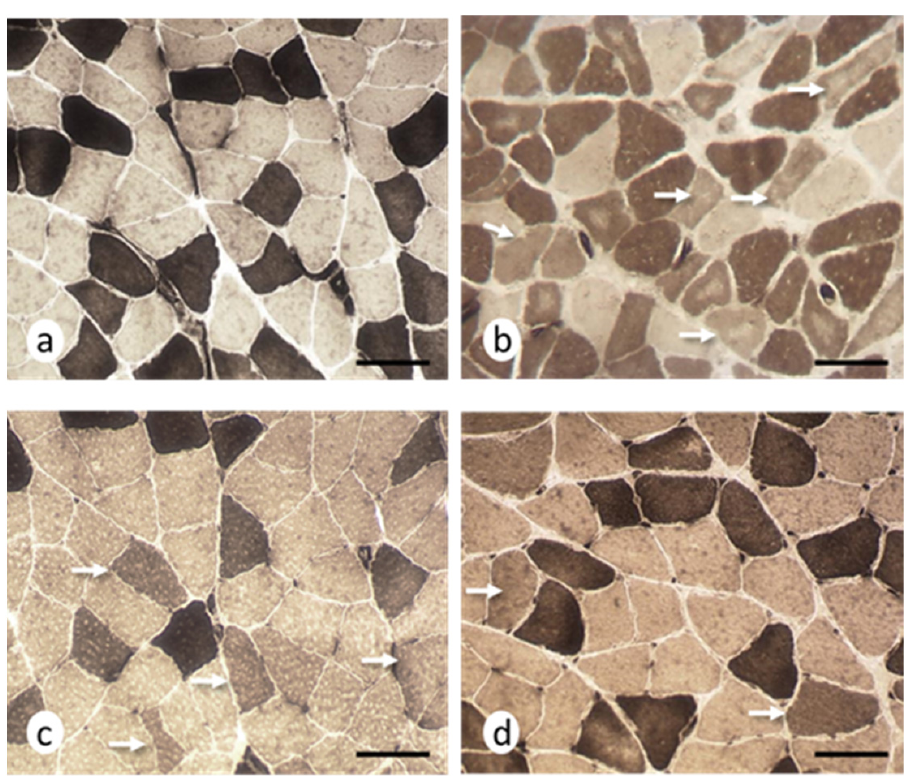
Figure 3. Histochemical evidence of intermediate fibers at day 36. Cross-sections of soleus muscles, ( a ) control group: two histochemical types were observed, type 1 (light) and type 2 (dark) fibers; ( b ) EAE group: fibers with intermediate staining (arrows), some of which showed a central area lacking histochemical activity (core fibers); ( c ) EAE + NTZ group: intermediate fibers (arrows) were observed, some of them with sharp edges; ( d ) EAE + TMS group: the arrows indicate intermediate fibers of an apparently normal size. adenosine triphosphatase (ATPase), pH 9.6. Scale bars = 40 μ m.